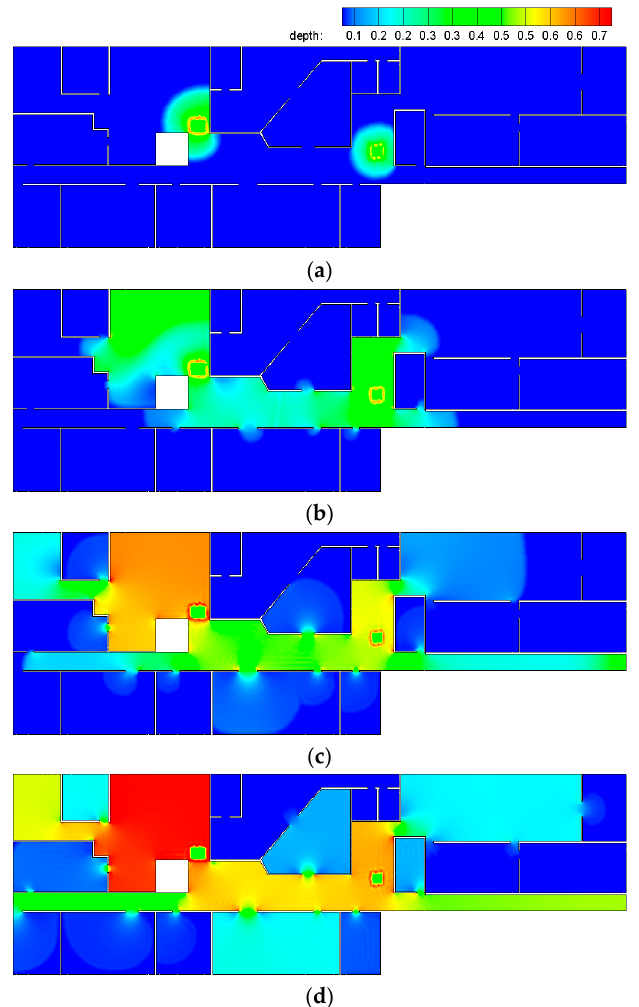
Figure 9. Inundation depth in the underground space (unit of contour legend: m); ( a ) t = 15 s; ( b ) t = 30 s; ( c ) t = 60 s; ( d ) t = 100 s.